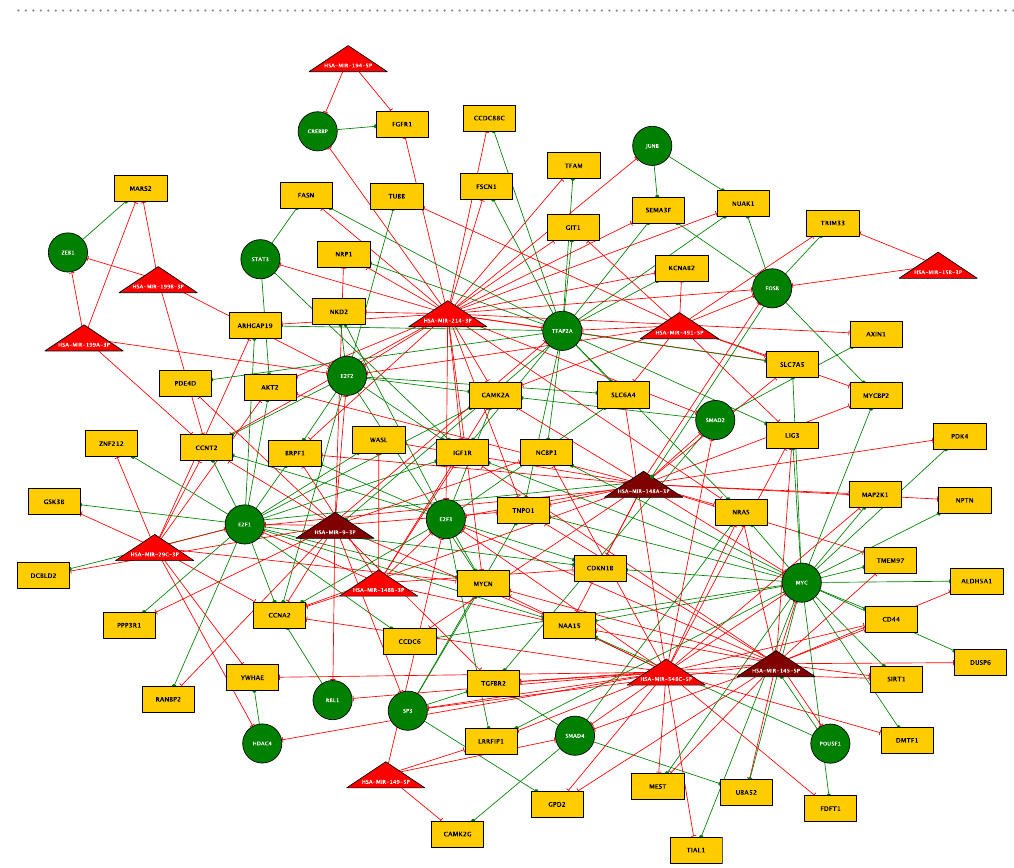
Figure 3. The proposed co-regulatory network of HCSC. The network created by MATLAB. Green circles are TFs, yellow rectangles are target genes, red triangles are miRNA, and purple triangles are miRNA acting also as TF target genes. Red edges are directed from miRNA, while green edges directed from TF to their